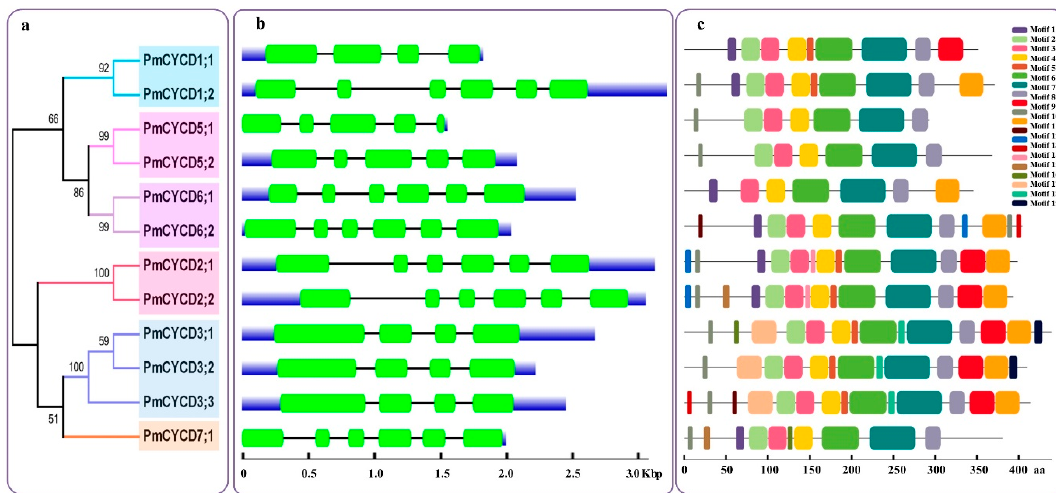
Figure 2. Phylogenetic relationship and motif distribution of PmCYCDs . ( a ) Mutiple alignments of 12 full ‐ length protein sequences of PmCYCDs were performed by MEGA 5.0. The 12 PmCYCDs proteins were clustered into six phylogenetic sub ‐ families. Each sub ‐ family is marked with different background colors; ( b ) Exon-intron structures of PmCYCDs . Exons and introns are indicated by green rectangles and horizontal lines, respectively. The scale estimates the lengths of exons and introns. ( c ) Motif distribution of PmCYCDs. Schematic representation of the conserved motifs in PmCYCD proteins were identified by MEME. Each motif is presented by a different colored block.